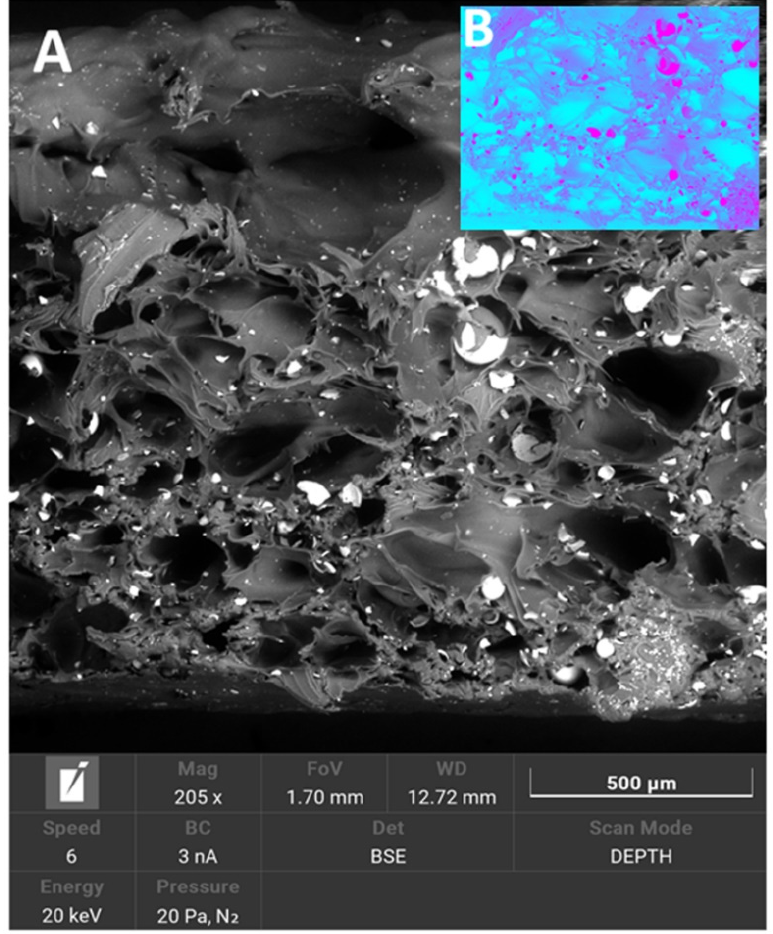
Figure 14. SEM microphotographs: breakthrough PA-12_CS samples: ( A ) SEM image, ( B ) image showing the marked inhomogeneous distribution of CSs in the matrix (concentrations of saturated pink color).